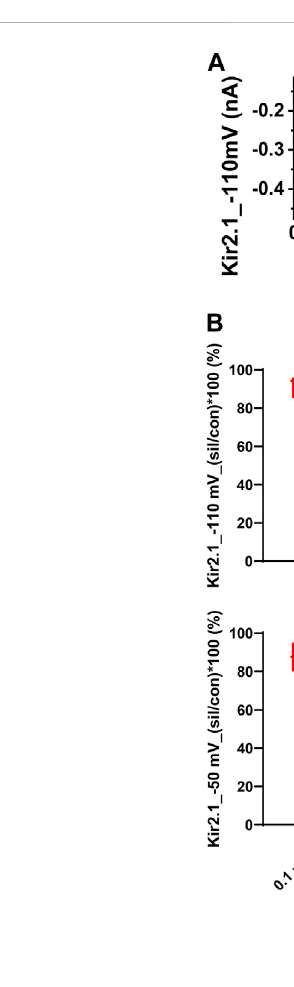
Potentiation of the effect of sildena fi l on the human Kir2.1 channels by a low concentration of Ba 2+ . (A) Time course of Kir2.1 changes in a representative cellincontrol(con),duringtheapplicationof0.1 µMsildena fi l(sil)aloneorincombinationwith0.1 µMBa 2+ . (B) Effectof0.1 µMsildena fi l(sil),0.1 µMBa 2+ ,and their combination in the relative scale at − 110 and − 50 mV (upper and lower graphs, respectively, in the left panel) and comparison of the effect of 0.1 µM sildena fi l in the absence and presence of 0.1 µM Ba 2+ at − 110 and − 50 mV (upper and lower graphs, respectively, in the right panel; n = 8); *, **, and *** — statistical signi fi cance at p < 0.05, 0.01, and 0.001, respectively (coloured stars in Figure 4B, left panel, show the statistical signi fi cance of the respective drug concentration vs.